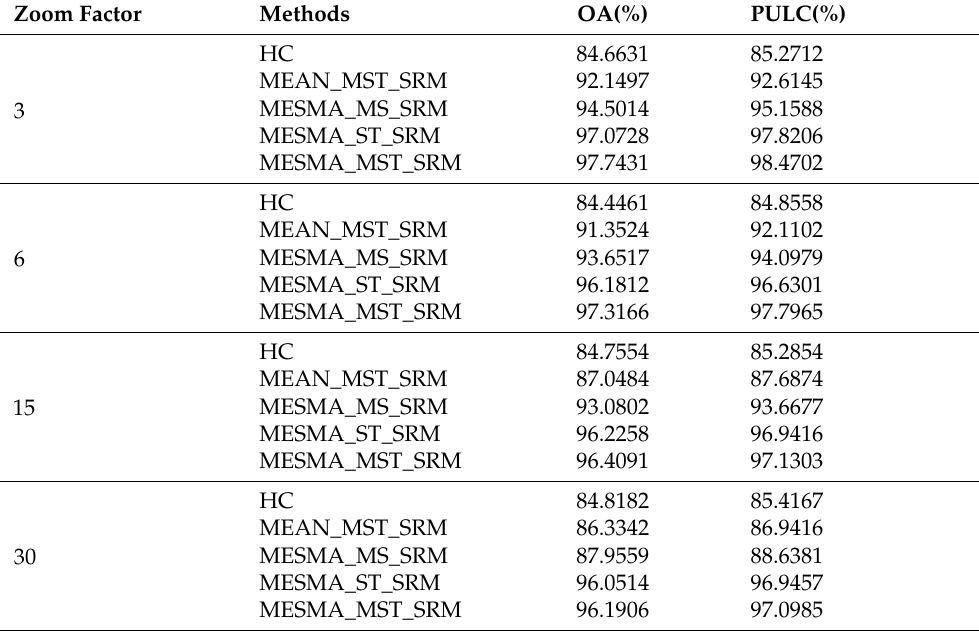
Table 5. Accuracy statistics of South Lake with Different Zoom